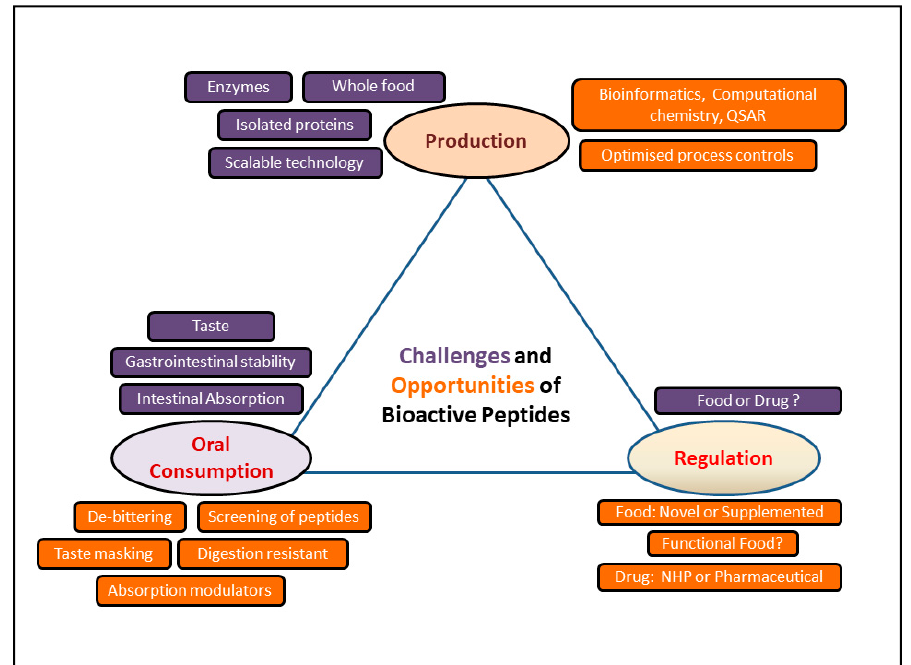
Figure 1. Challenges and potential solutions to utilization of bioactive peptides in human